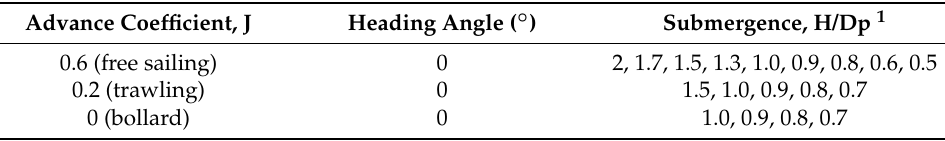
Table 3. Simulation conditions in presence of free surface.